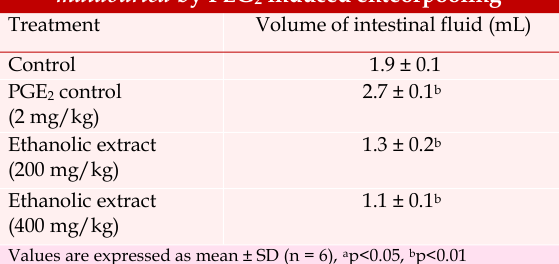
Anti-diarrheal activity of ethanolic extract of D. malabarica by PEG 2 induced enteorpooling